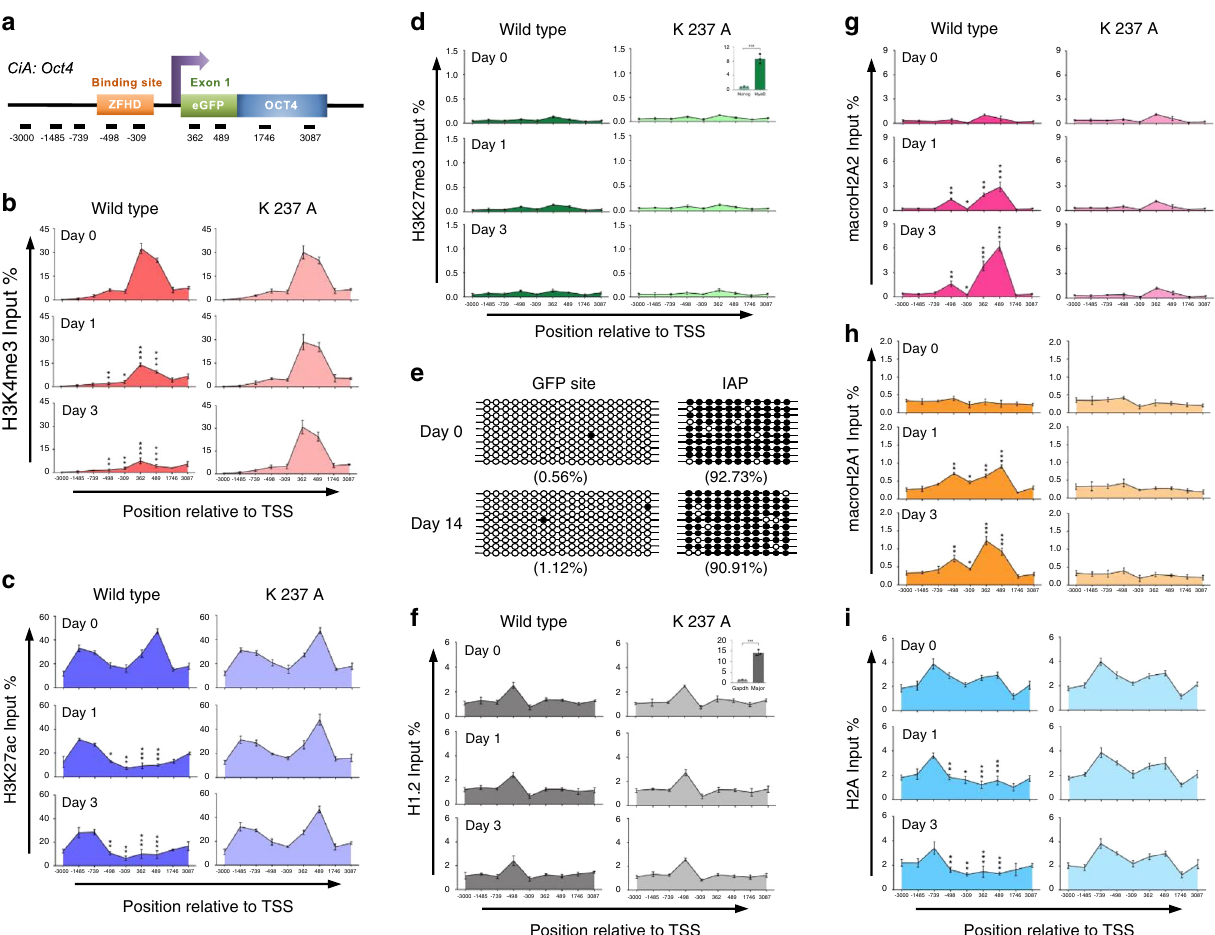
Fig. 2 LSH recruitment induces macroH2A deposition at the tethered locus. a Schematic representation of primer location at the CiA: Oct4 allele; allele- speci fi c primers at ZFHD binding ( − 498, − 309) and eGFP sites (362, 489), and common primers of the Oct4 gene ( − 3000, − 1485, − 739, 1746, and 3087). b – d ChIP-qPCR analysis to assess the dynamic changes of histone modi fi cations H3K4me3 ( b ), H3K27Ac ( c ), and H3K27me3 ( d ) at the CiA: Oct4 locus in the wild-type and ATP mutant LSH (K 237A) CIP systems after 0, 1, and 3 days of rapamycin treatment. Nanog and MyoD genes were used for H3K27me3 ChIP-qPCR results as negative and positive controls, respectively. *adjusted p < 0.05, **adjusted p < 0.01, and ***adjusted p < 0.001. e Bisul fi te sequencing analysis shows no changes of CG methylation level at eGFP site following LSH recruitment by rapamycin for 14 days. IAP repeat sequence served as positive control for bisul fi te sequencing analysis. The CpG methylation pro fi les are shown with black (methylated) and white (unmethylated) circles. Each sample included 10 sequenced clones and is represented as percentage of methylated CpGs. f – i ChIP-qPCR analysis to assess the dynamic changes of histones and variants H1.2 ( f ), macroH2A2 ( g ), macroH2A1 ( h ), and H2A ( i ) at the CiA:Oct4 locus in the wild-type and ATP mutant LSH (K 237A) CIP systems after 0, 1, and 3 days of rapamycin treatment. Gapdh and Major satellite genes were used as negative and positive controls for H1.2 ChIP-qPCR result. *adjusted p < 0.05, **adjusted p < 0.01 and ***adjusted p < 0.001. One-way ANOVA with Tukey ’ s multiple comparison test ( b – d , f – i ). b – d , f – i representative of three independent experiments. Data are represented as mean ± SD. Source data are provided as a Source Data fi